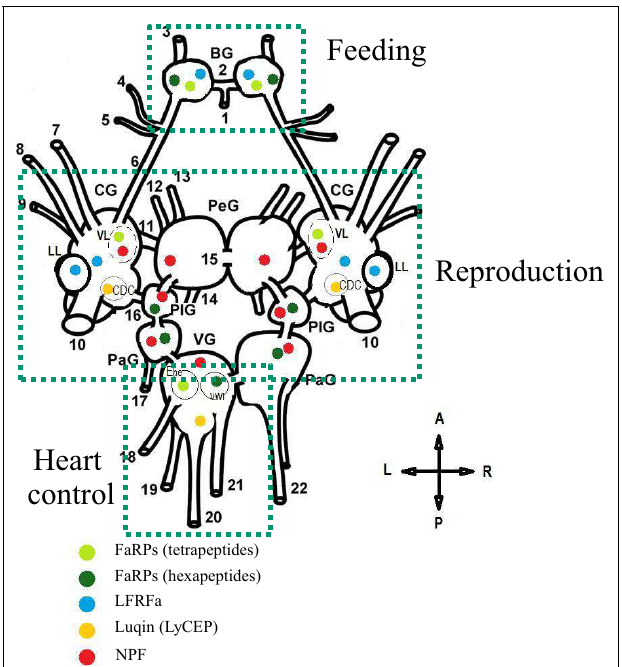
FIGURE 5 | Schematic representation of the distribution and the role of distinct RFamide-like peptides (FLPs) in the central nervous system (dorsal view) of Lymnaea stagnalis . BG, buccal ganglion; CG, cerebral ganglion; PeG, pedal ganglion; PlG, pleural ganglion; PaG, parietal ganglion; VG, visceral ganglion;VL, ventral lobe; LL, lateral lobe; CDC, caudo-dorsal cell. Nerves: 1, postbuccal; 2, buccal commissure; 3, dorsobuccal; 4, laterobuccal; 5, ventrobuccal; 6, cerebro-buccal connective; 7, superior lip; 8, median lip; 9, tentacular; 10, cerebral commissure; 11, cerebro-pedal connective; 12, superior medial; 13, median pedal; 14, inferior pedal; 15, pedal commissure; 16, cerebro-pleural connective; 17, left parietal; 18, cutaneous; 19, anal; 20, intestinal; 21, genital; 22, right parietal. Ehe neuron and the visceral white interneuron (VWI) [Adapted from Ref. (72, 104, 130, 141,